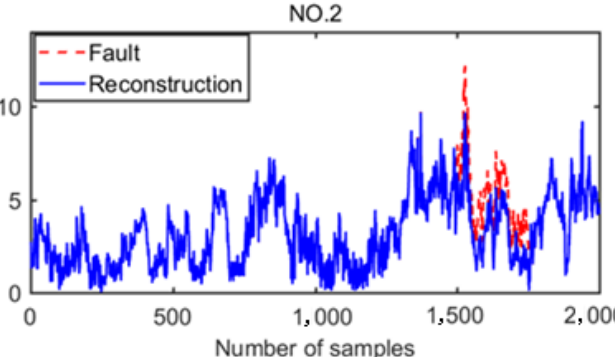
Figure 4. No. 2 faulty wind speed and reconstructed wind speed.